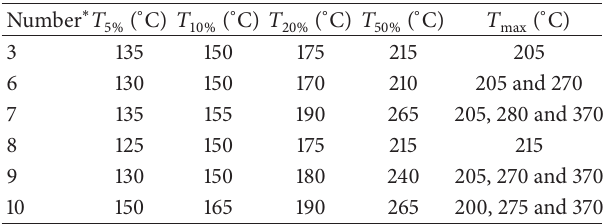
∗ Number according to Table 2 . Table 5: Thermal stability of reaction products of EBU with PC.